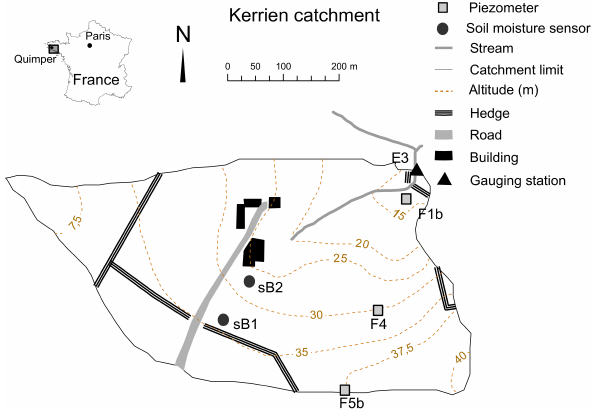
Figure 1. Study site in west Brittany (indicated by the square near Quimper) and location of the monitoring equipments. The weather station is located 500m north of the